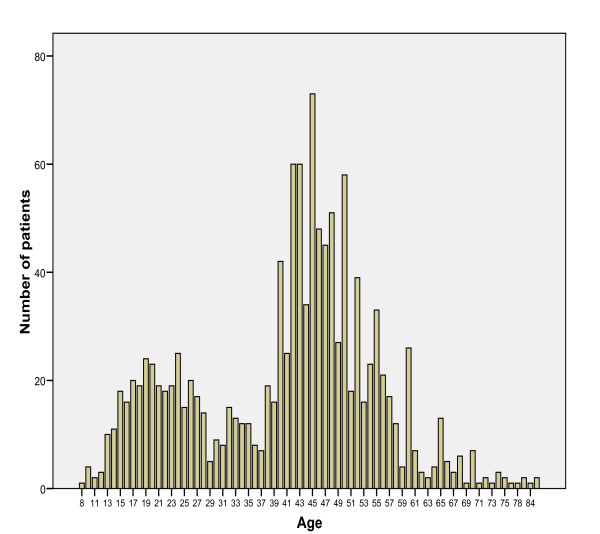
Age distribution of the patients.